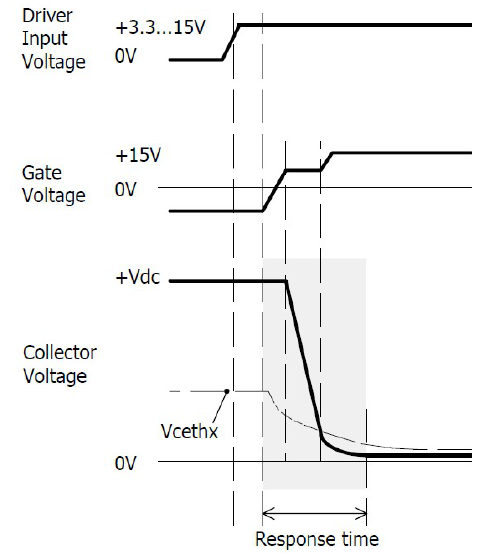
Figure 22. Turn-on characteristics of an IGBT.